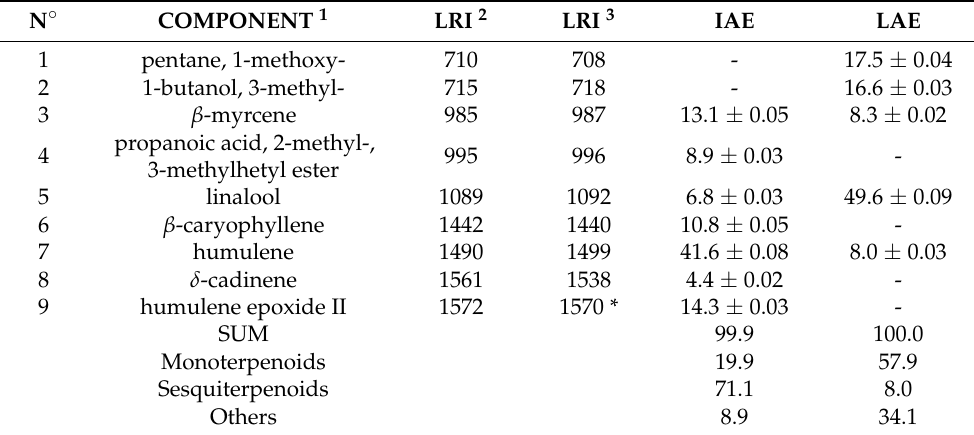
Table 2. Chemical volatile composition (percentage mean value ± standard deviation) of aqueous extracts from hops inflorescences and leaves, as determined by DI-SPME-GC-MS. N ◦